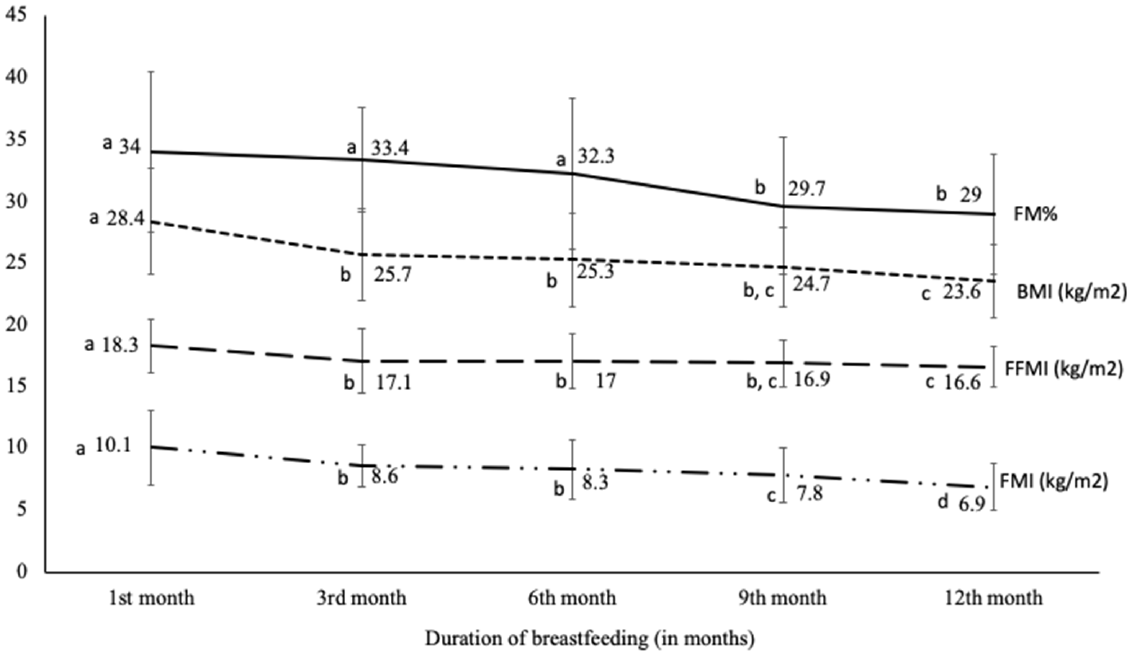
Figure 3. Longitudinal changes in: mothers’ body mass index, mothers’ fat mass percentage, mothers’ fat mass index and mothers’ fat free mass index from 1 to 12 months after birth measured with deuterium dilution technique. BMI: body Mass Index in kg/m 2 ; FM%: fat mass percentage, FMI: fat mass index in kg/m 2 ; FFMI: fat free mass index in kg/m 2 ; a, b, c and d: for each variable separately, the values with the same letters are statistically not different however, the values with different letters are statistically different.